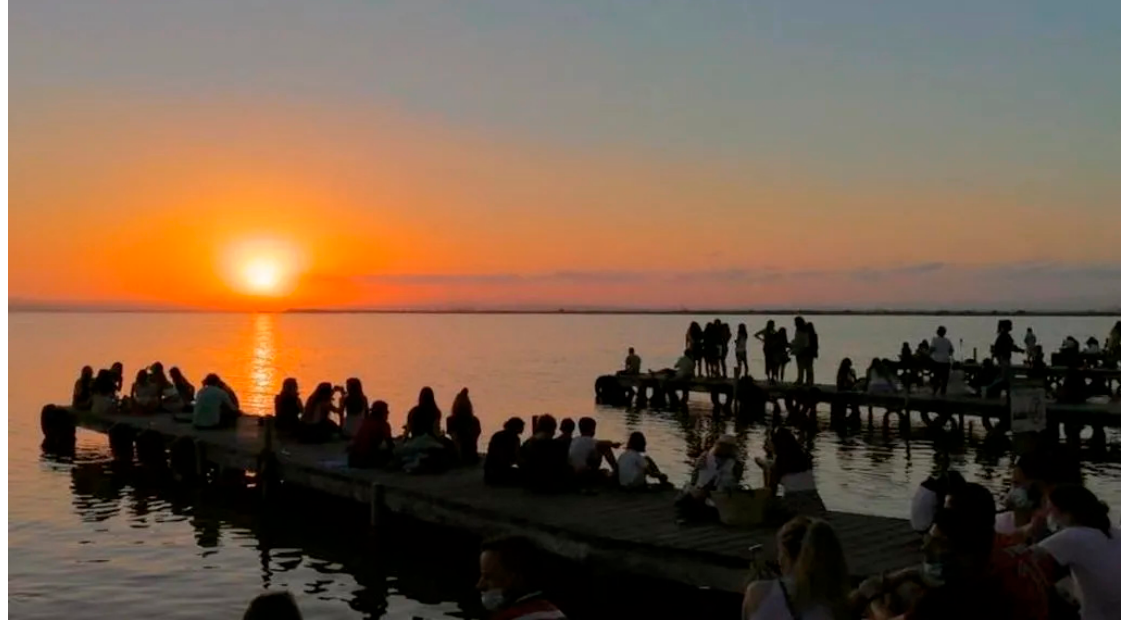
Figure A1. Sunset in Albufera of Valencia. Tourists watch the sun lowering on the horizon. Date: 28 August 2020. Source: https://album.mediaset.es/eimg/10000/2020/08/28/clipping_Jv3lJy_aea7.jpg accessed on: 10 March 2021.